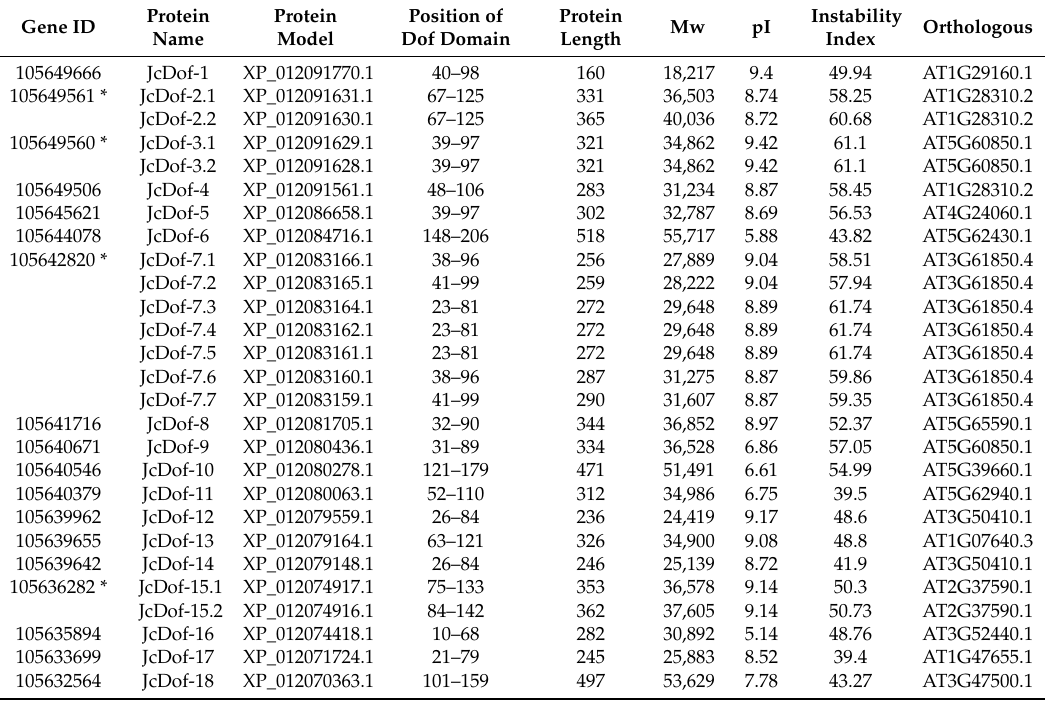
Table 1. The information of the JcDof gene